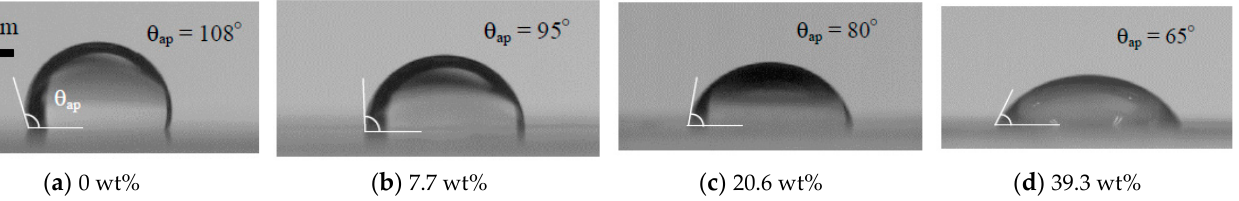
Figure 2. Droplet wettability of each liquid on silicone rubber (SR): ( a ) 0 wt% (0.072 Nm − 1 ), ( b ) 7.7 wt% (0.051 Nm − 1 ), ( c ) 20.6 wt% (0.038 Nm − 1 ) and ( d ) 39.3 wt% (0.030 Nm − 1 ). Droplet volume V 0 is 10 Figure 1. Schematic of ( a ) overall view of experimental apparatus and ( b ) view A in ( a ) where the μ L. geometrical parameters are defined.